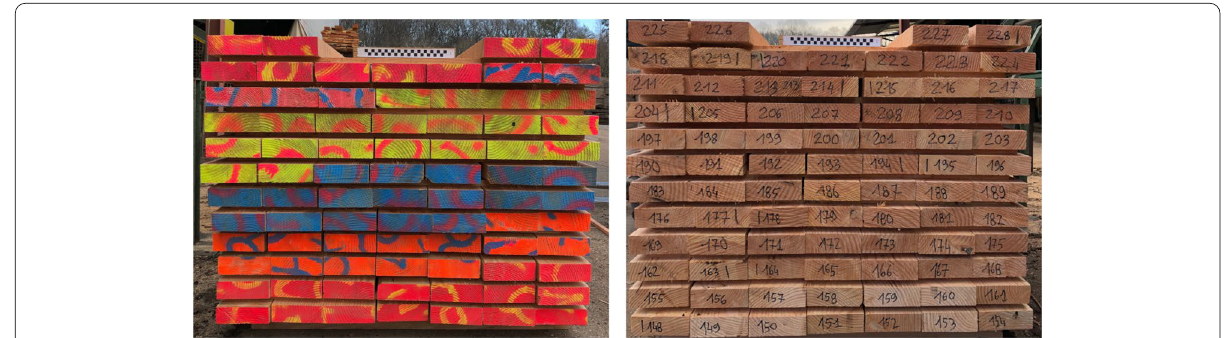
Fig. 8 A pile of boards at the sawmill: Small ends covered with paint on the left, large ends with board numbers on the right. The 25‑cm‑long scale was used to calibrate the images in